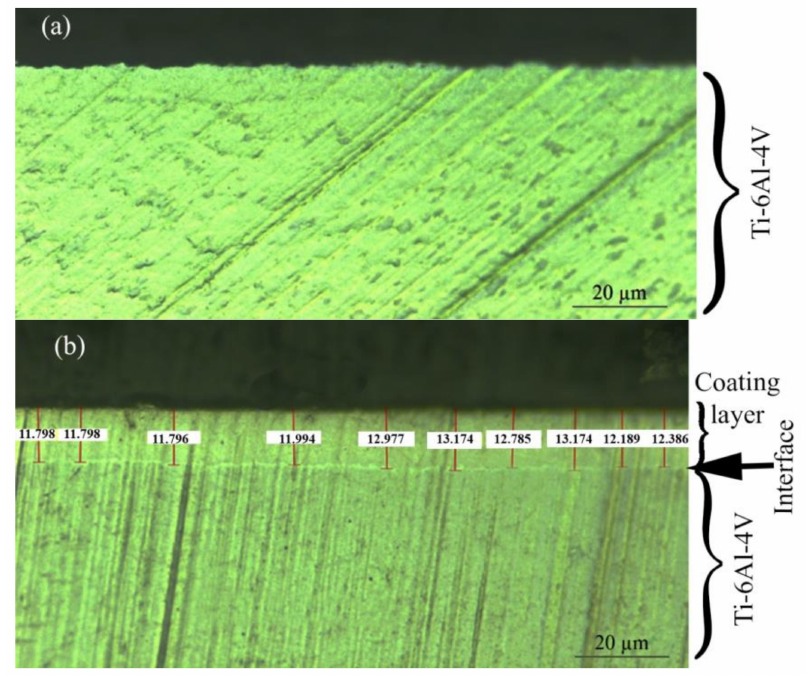
Figure 2. Section from ( a ) Ti-6Al-4V, ( b ) coated